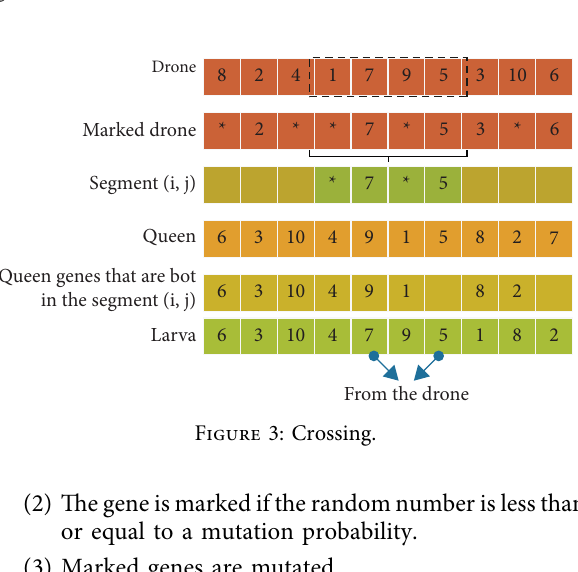
Figure 2: HBMO algorithm